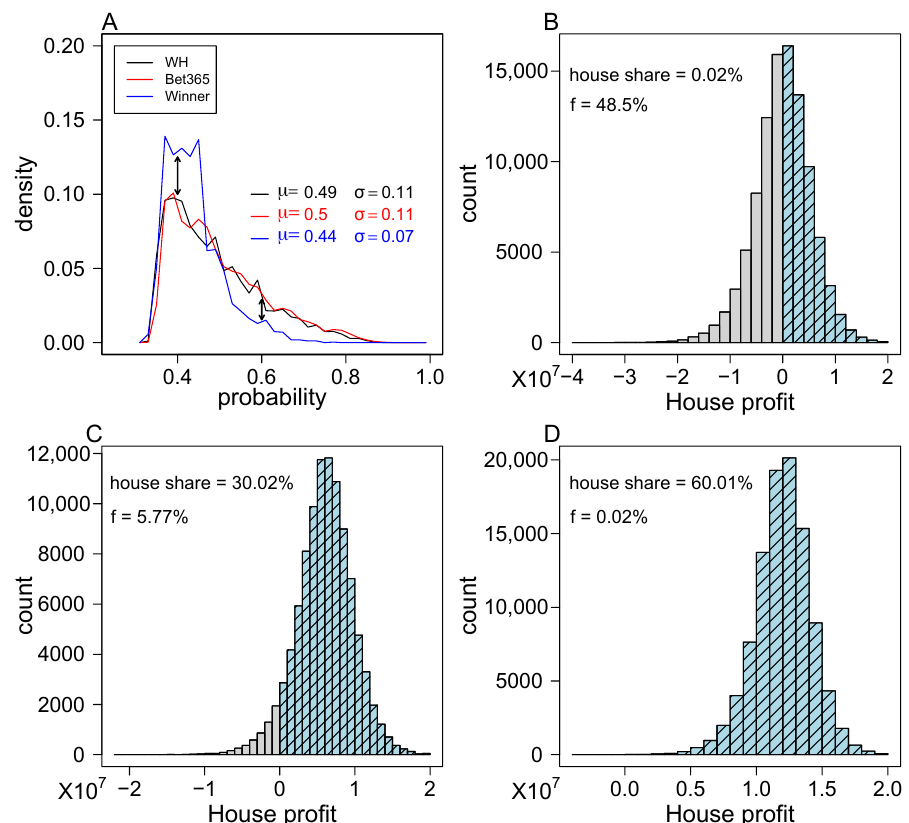
Figure 6. Expected house share of the proposed prize-pricing mechanism. ( A ) A distribution of the maximum probabilities for all single games of WINNER, William Hill and bet365. The x-axis corresponds to the maximum probabilities for all single games provided by the gambling houses, and the y-axis corresponds to their density. ( B – D ) Histograms of the house share for the proposed prize-pricing mechanism with three levels of α . A total of 100,000 simulations were conducted and the house share was recorded in all of them for α = 0 ( B ), α = 0.3 ( C ), and α = 0.6 ( D ). The profitable rounds are shown in light blue and the non-profitable in gray. The f value indicated on the graphs refers to the fraction of non-profitable simulated